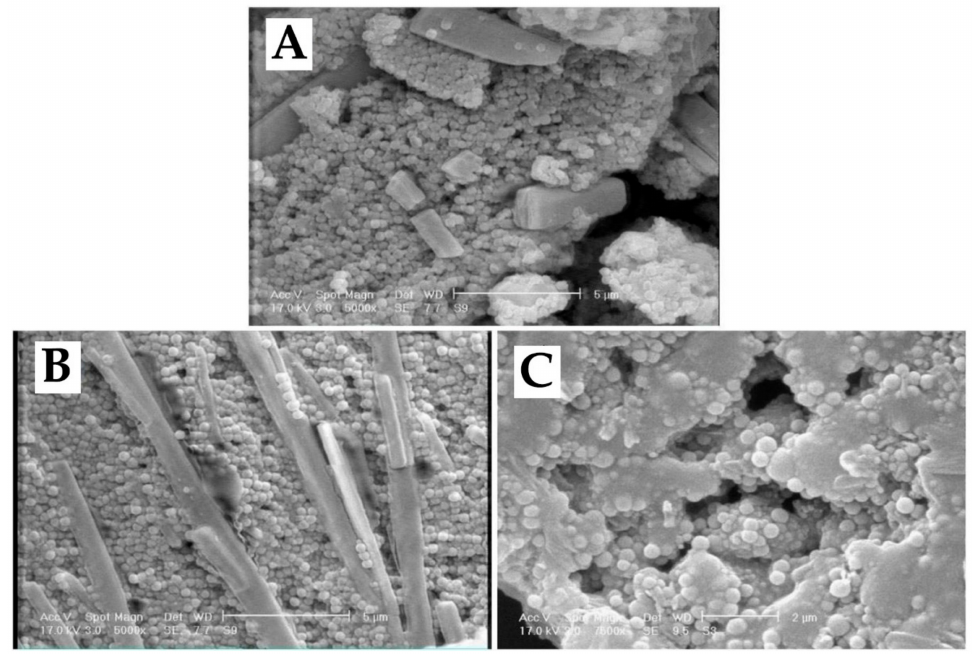
Figure 2. Scanning electron microscopy (SEM) images of ( A ) liposome, ( B ) LCispt, and ( C ) PLCispt prepared by the reverse-phase evaporation